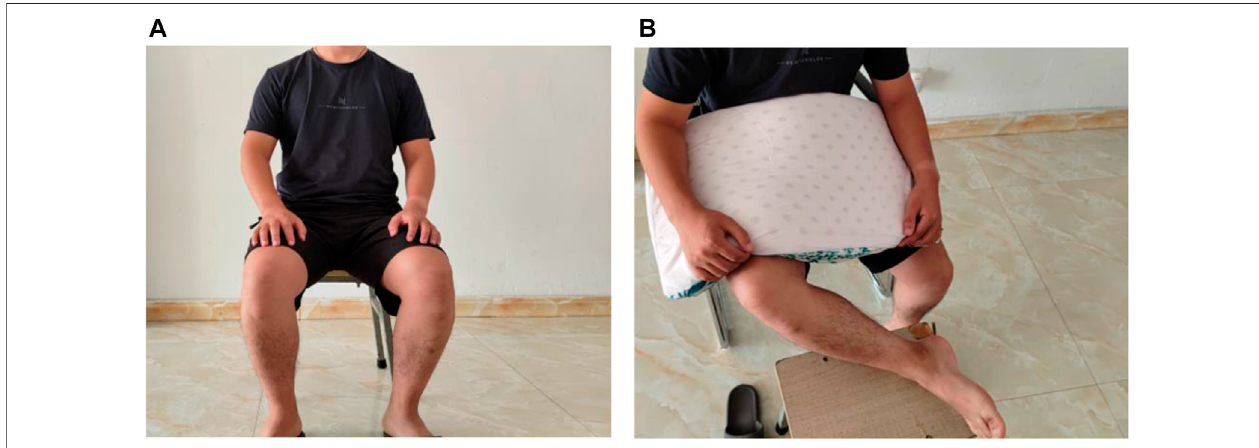
FIGURE 1 | Schematic diagram of the human body model. (A) Positioning ACJ and TFJ in this position. (B) Positioning LHBT and PTT in this